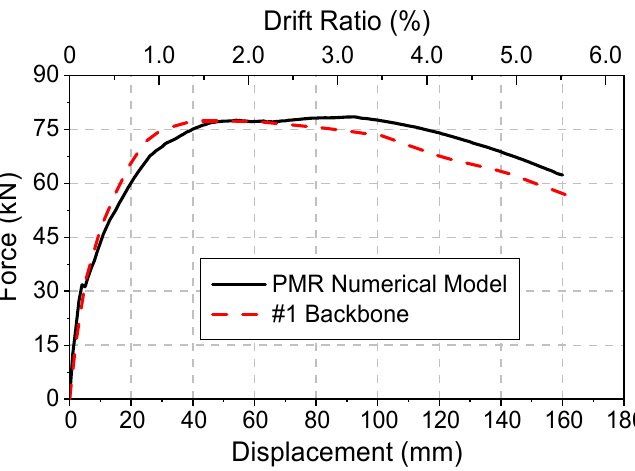
Figure 5. Force–displacement curve of PMR and the backbone curve in the test.